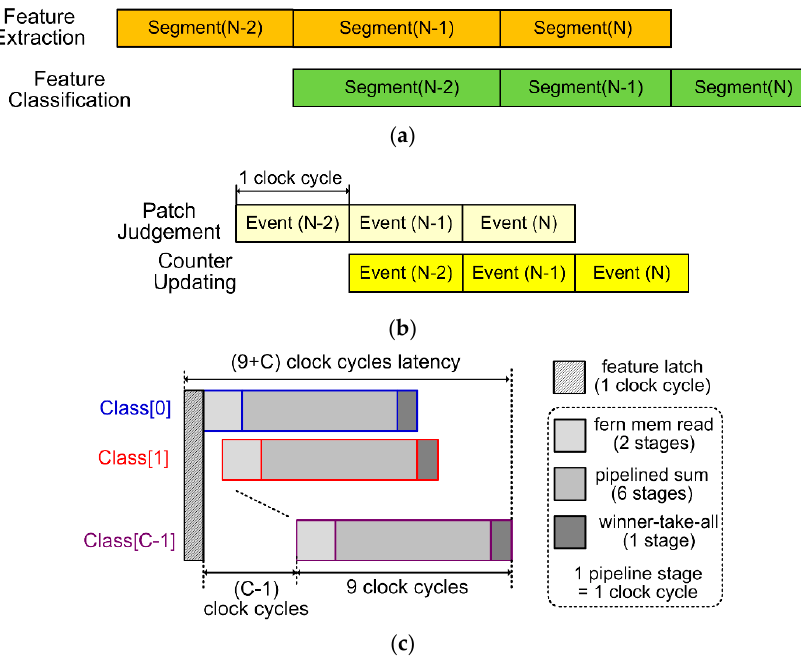
Figure 2. Multi-level pipelines. ( a ) The course-grained segment-level pipeline. ( b ) The fine-grained event-level pipeline in the feature extractors. ( c ) The fine-grained feature-level pipeline in the Random Ferns engine.